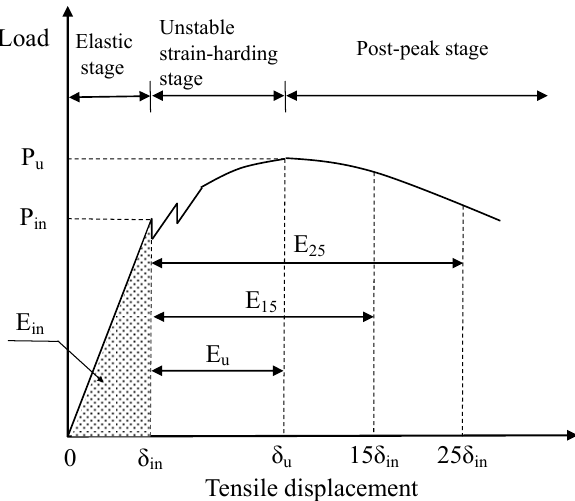
Figure 7. Illustration of determination of energy absorption capability of reactive powder concrete.